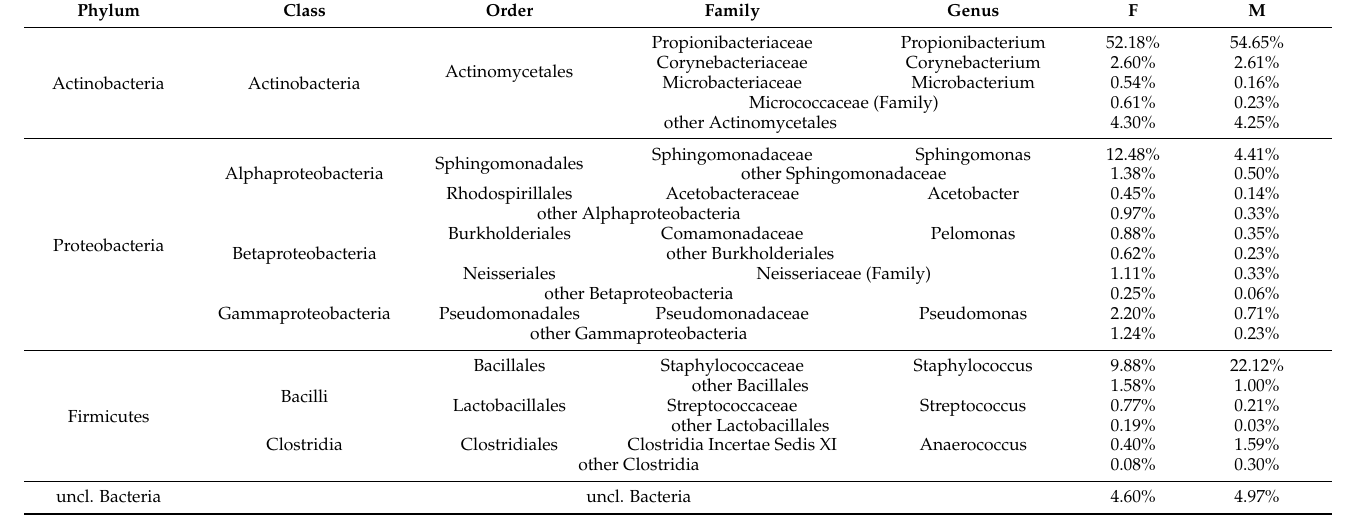
Table 4. Relative abundance of the most abundant genera and of their most representative parent taxa.